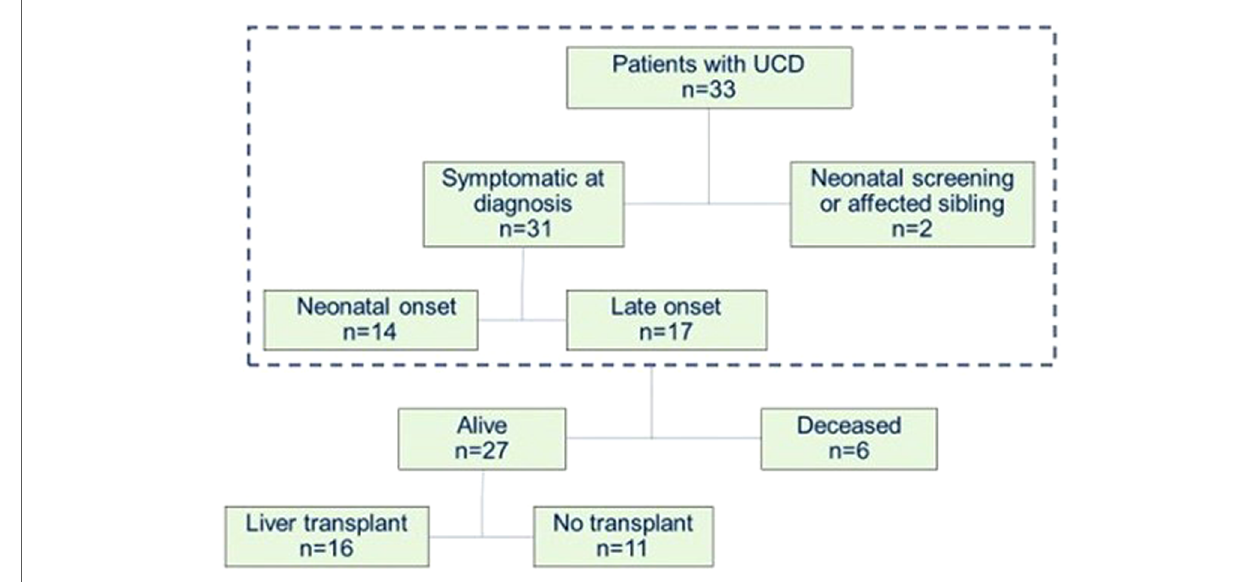
FIGURE 1 Characteristics of patients diagnosed with a UCD at La Paz University Hospital between January 2000 and December 2021.